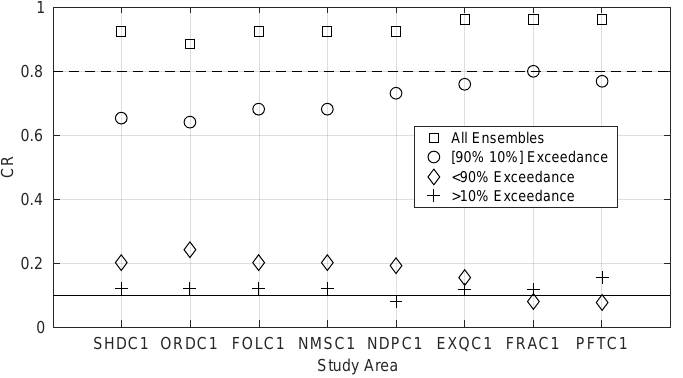
Figure 6. Median values of containing ratios from 1 October to 1 May of different categories of ensemble forecasts for the study watersheds. The dash line indicates the ideal containing ratio (0.8) for the 10% and 90% exceedance forecasts; the solid line represents the ideal containing ratio (0.1) for less than 90% exceedance and greater than 10% exceedance